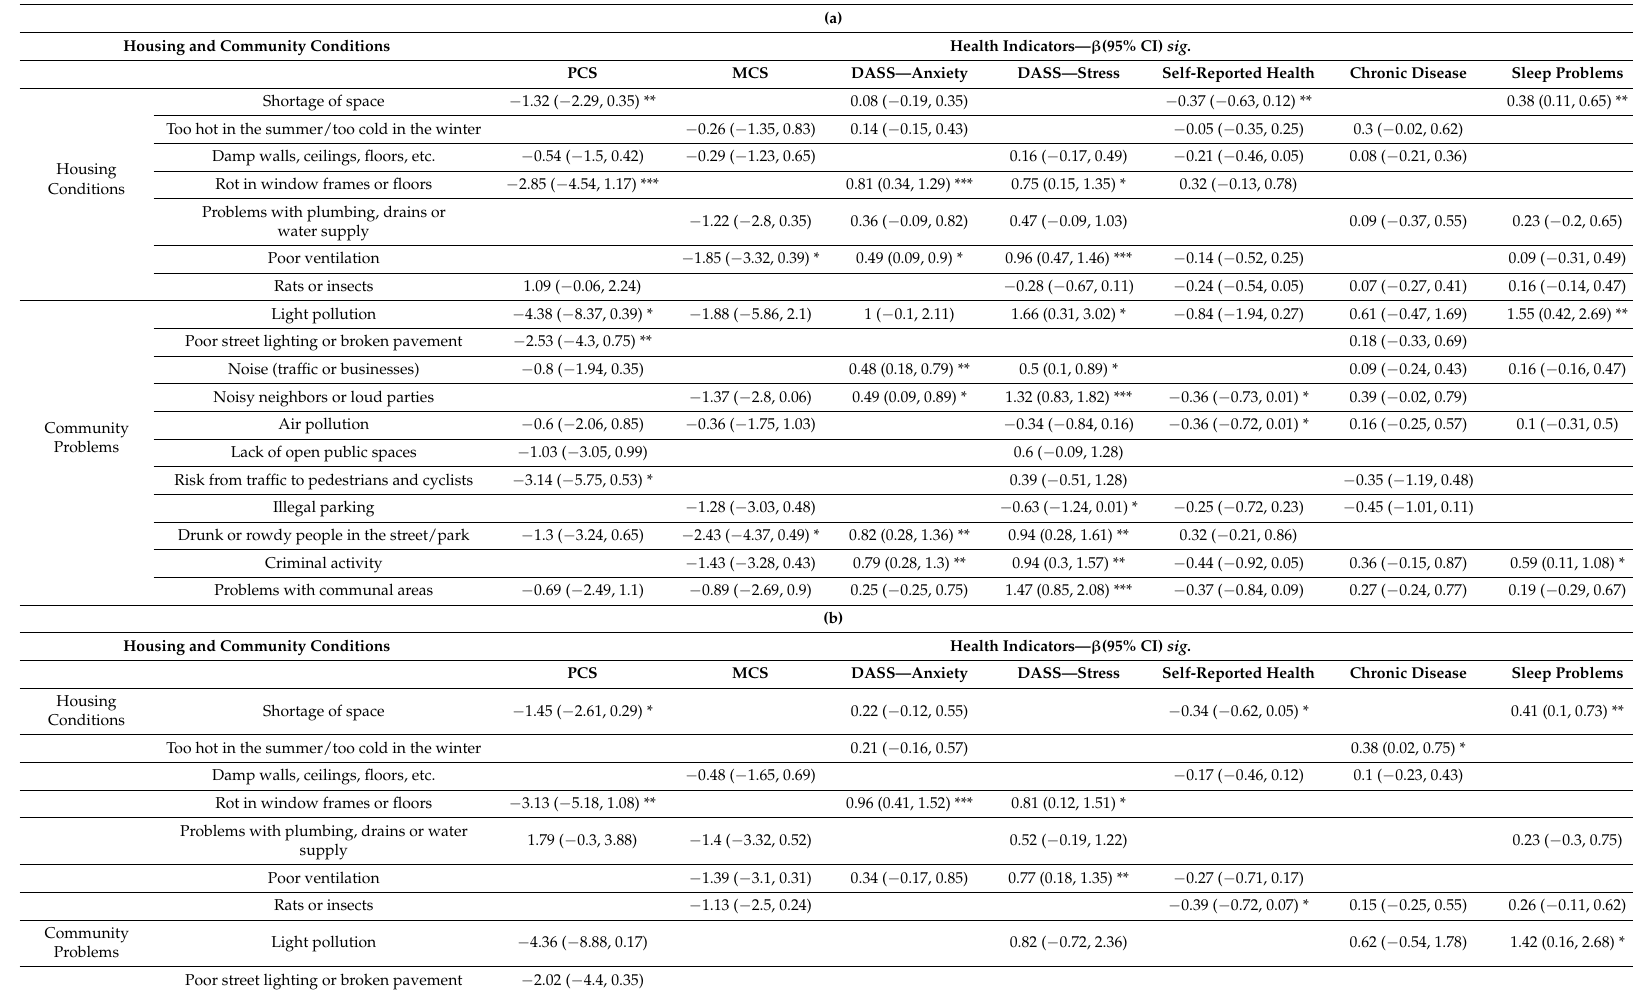
Table 3. (a) Impact of housing and community problems on the whole population (results of a linear/logistic regression). (b) Impact of housing and community problems on the middle- to low-income group (results of a linear/logistic